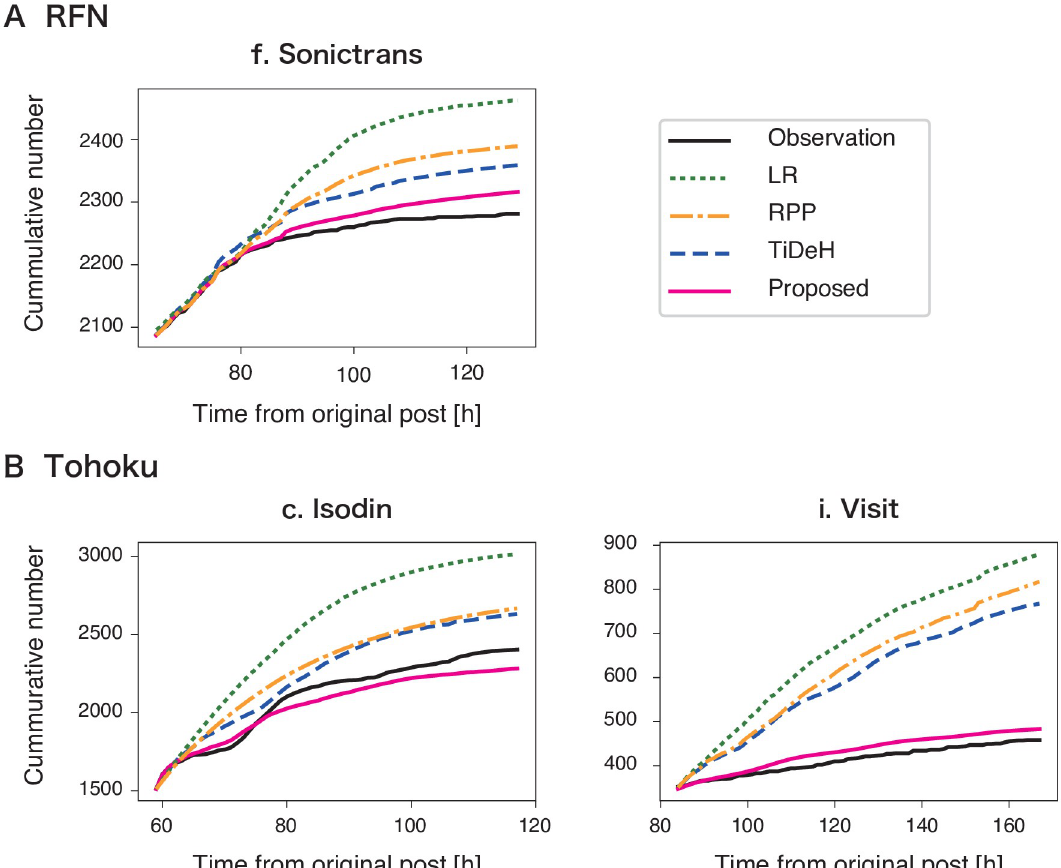
Fig 4. Predicting time series of the cumulative number of posts related to a fake news item. Prediction results from (A) RFN and (B) Tohoku datasets are shown. Green, orange, and blue dashed lines represent the prediction results of the baselines (LR, RPP, and TiDeH, respectively). The black and magenta lines represent the observations and their prediction results of the proposed model.